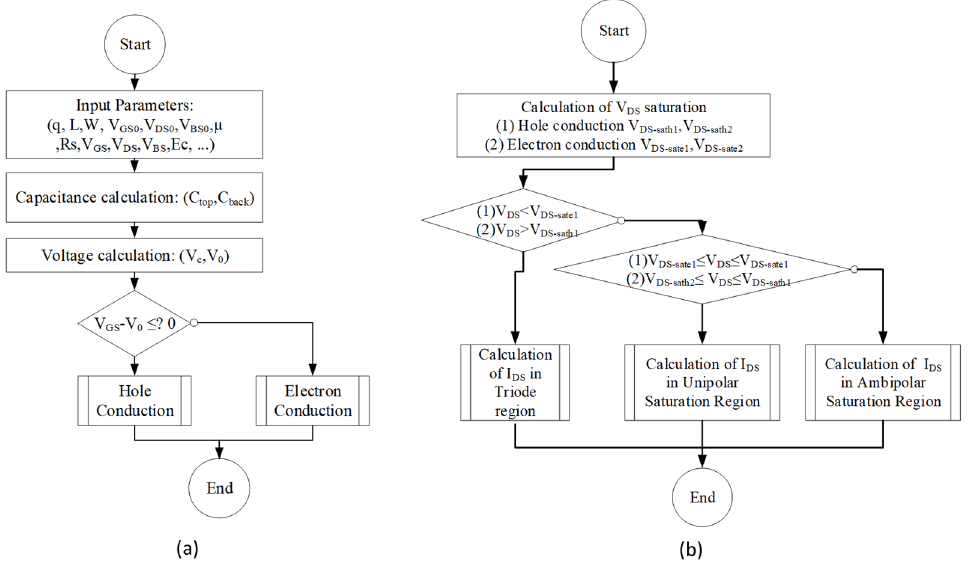
Figure 9. Flowchart of graphene transistor model: ( a ) Principal code (Level 0); ( b ) (1) hole and (2) electron conduction functions.